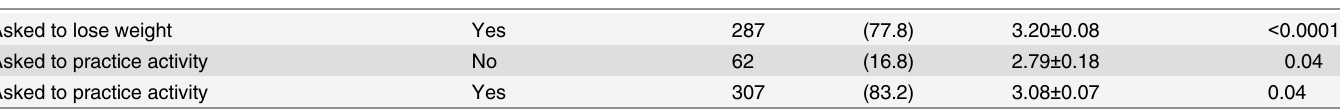
patients and their practitioners were “ the fear of suffering a heart attack ” (2.9±0.2/3.1±0.1, “ their physical health status ” (4.4±0.2/3.5±0.1), and “ a low fitness level ” (3.1±0.3/3.9±0.1). The clustering effect evaluated by ICC between type 2 diabetes patients and GPs was 34%, which is considered to be a high value [9]. Using mixed model, type 2 diabetes patient ’ s BAPAD score was linked with all patient ’ s characteristics including gender (Table 3). A high BAPAD score reflecting a high barrier to PA was significantly and positively correlated with duration of diabetes ( > 8 years) (p = 0.002). The patient ’ s BAPAD score was significantly